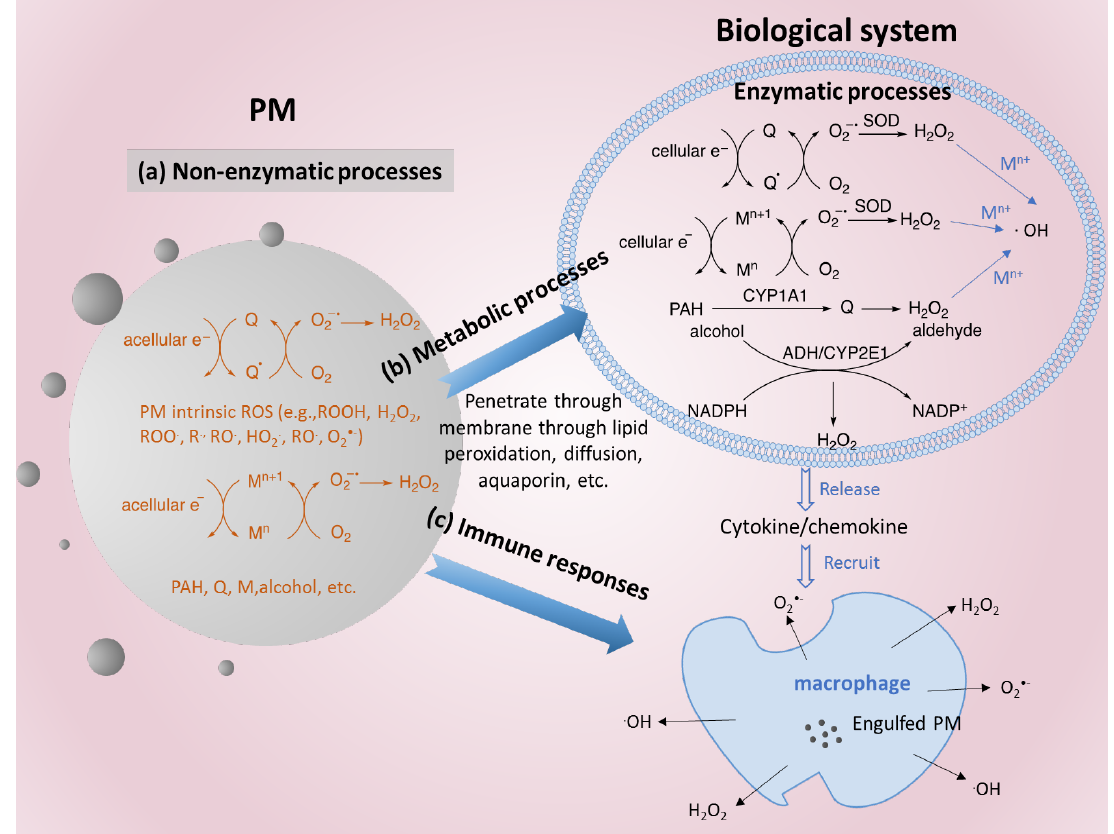
Figure 2. The production of PM-bound reactive oxygen species (ROS) through ( a ) non-enzymatic processes, and PM-induced ROS through ( b ) metabolic processes (i.e., enzymatic reactions) and ( c )